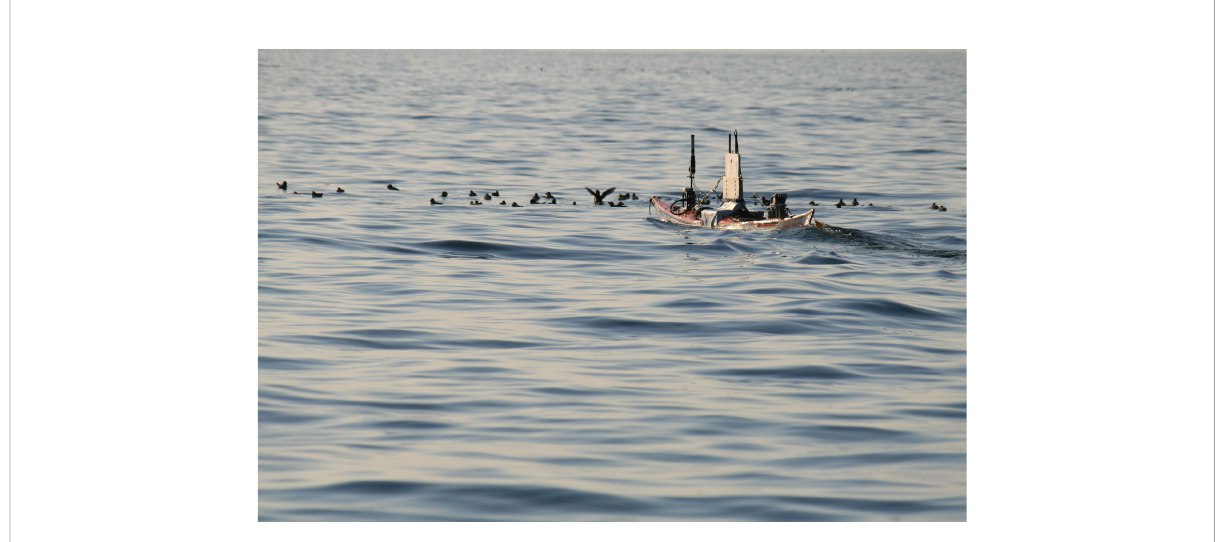
FIGURE 8 The Kayak Drone approaching seabirds next to the Runde bird cliffs,